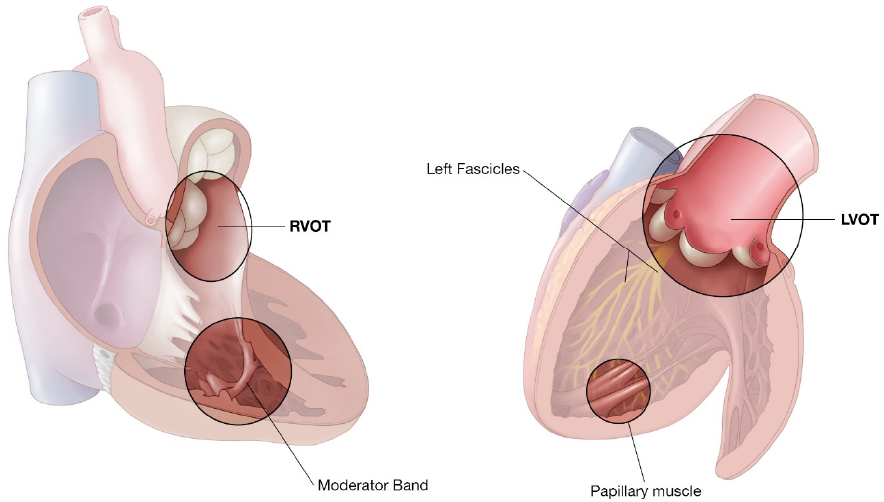
Figure 1. Representative illustration of the right ventricle and left ventricle highlighting common locations of idiopathic VT.